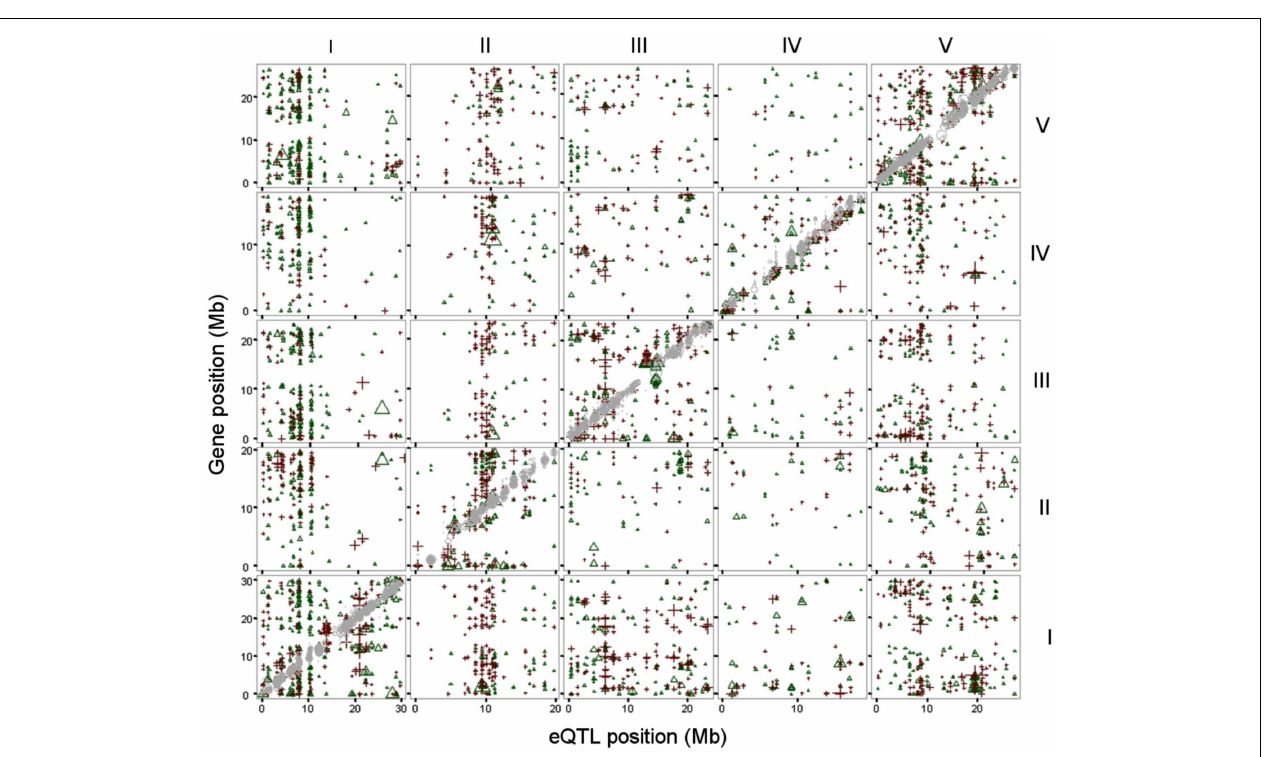
(diagonal). eQTLs with a L er positive effect are depicted as green triangles, eQTLs with a Cvi positive ( = L er negative) effect as red plus signs. Chromosomes are indicated on the right for rows and on top for columns of graphs.